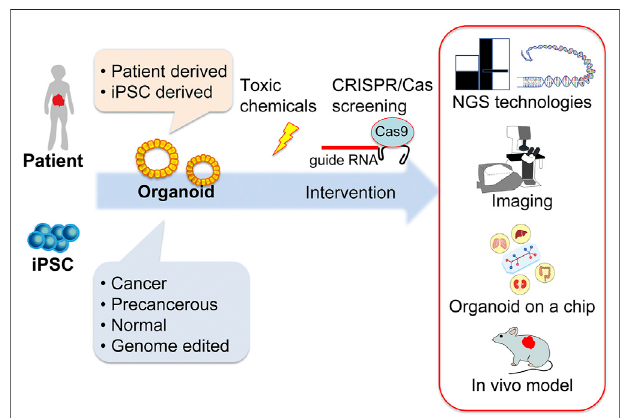
FIGURE 1 | Schematic illustration of human organoid and supporting technologies for cancer and toxicological research. Human organoids can be established from patient- or human-induced pluripotent stem cells that are either cancerous, precancerous, normal, or genome-edited. These organoids serve as screening tools for toxic chemicals in combination with CRISPR/Cas technologies. Cutting-edge techniques, such as genome sequencing using NGS and RNA sequencing technologies, imaging technologies, culture devices, and the use of immunode fi cient animal models for in vivo experiments support organoid-based human biology research. CRISPR/Cas, clustered regularly interspaced short palindromic repeats/ CRISPR-associated protein; gRNA, guide RNA; iPSC, induced pluripotent stem cell; NGS, next-generation sequencing.